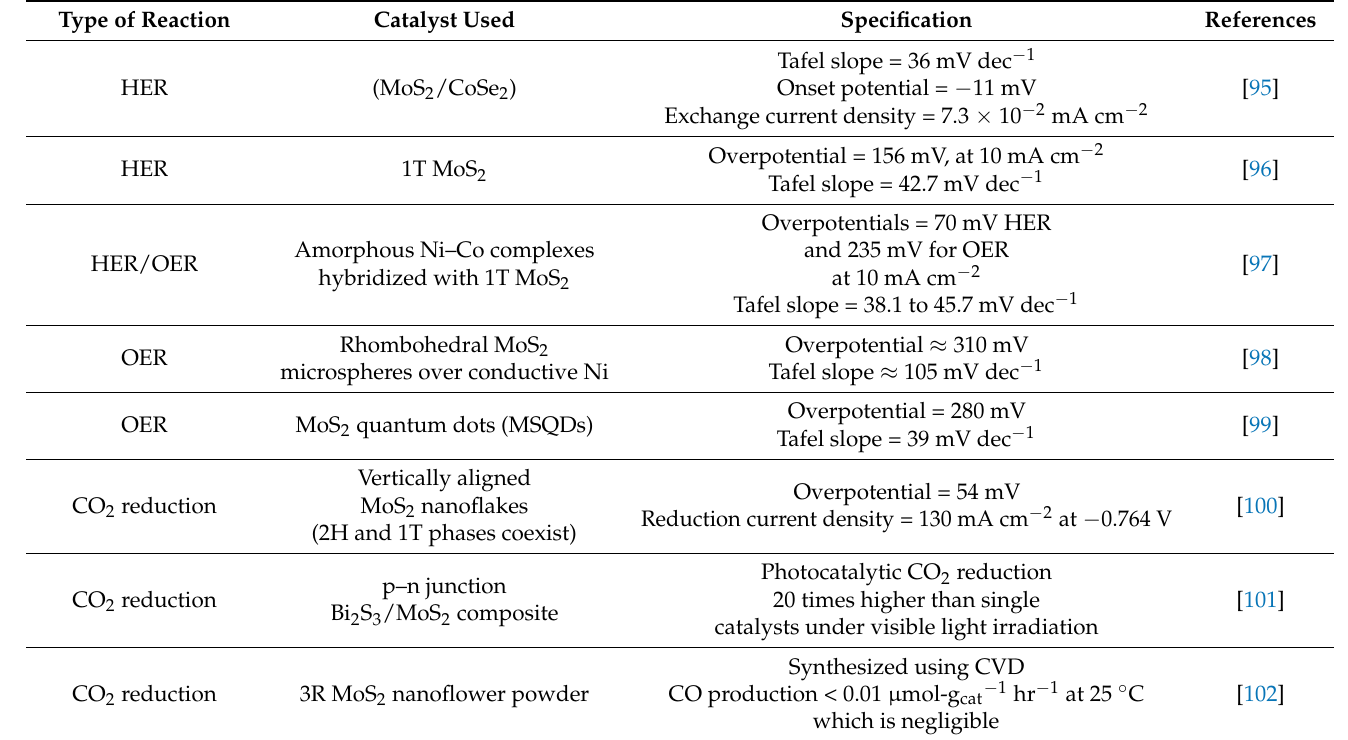
Table 3. Energy generation applications of different MoS 2 structures and